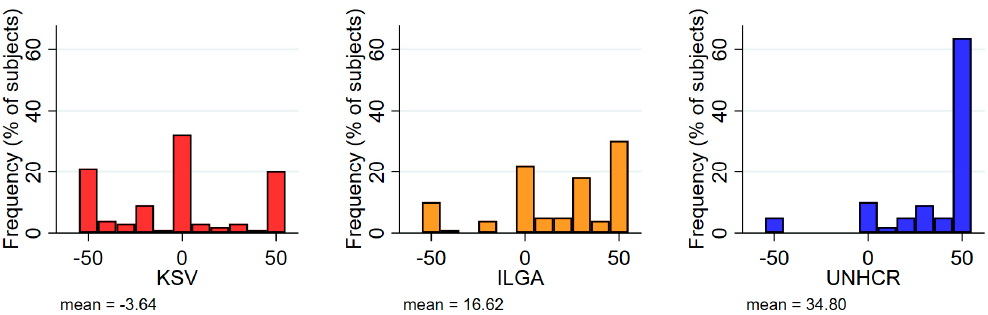
Figure 1. Distribution of DOT decisions for each organization.